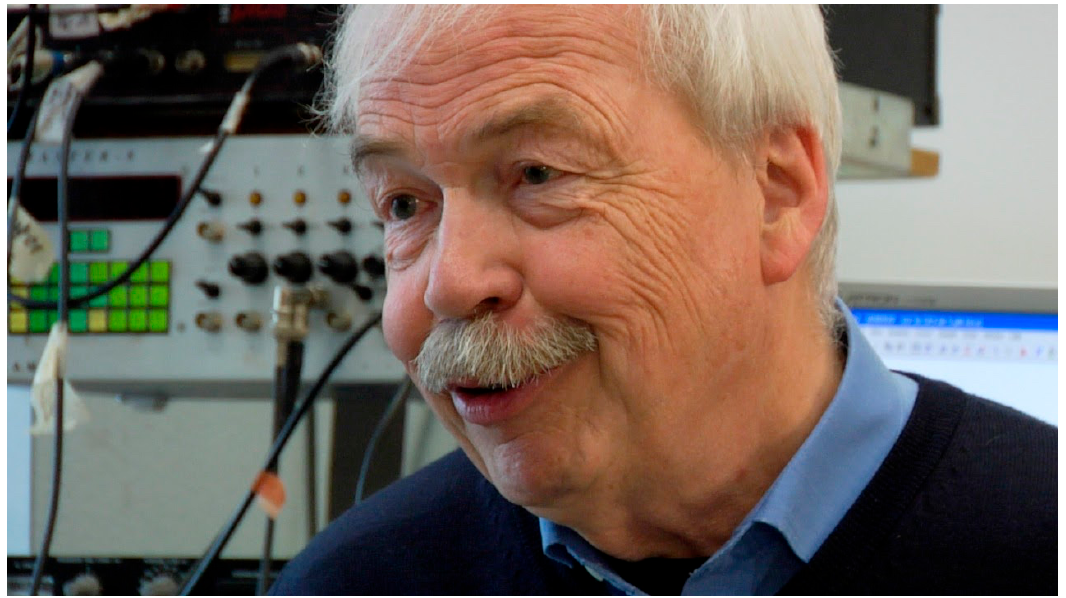
Figure 1. Uwe Heinemann (born 17 February 1944 in Genthin; died 8 September 2016 in Berlin).